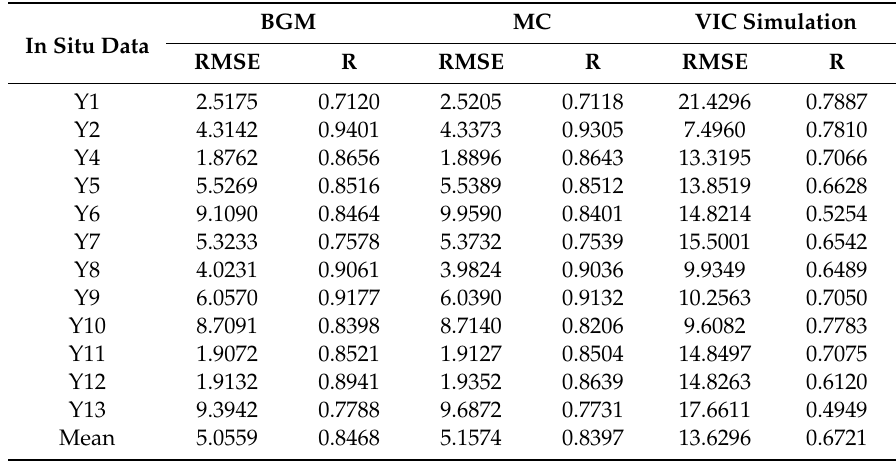
Figure 11. The RMSE ( a ) and R ( b ) of the data assimilation using the BGM method, the MC method and the VIC simulation experiments. Table 5. The RMSE and R of the assimilated values (using the BGM and MC methods) and the simulation experiment (VIC) spatially averaged over the grids where the in situ sites are located.